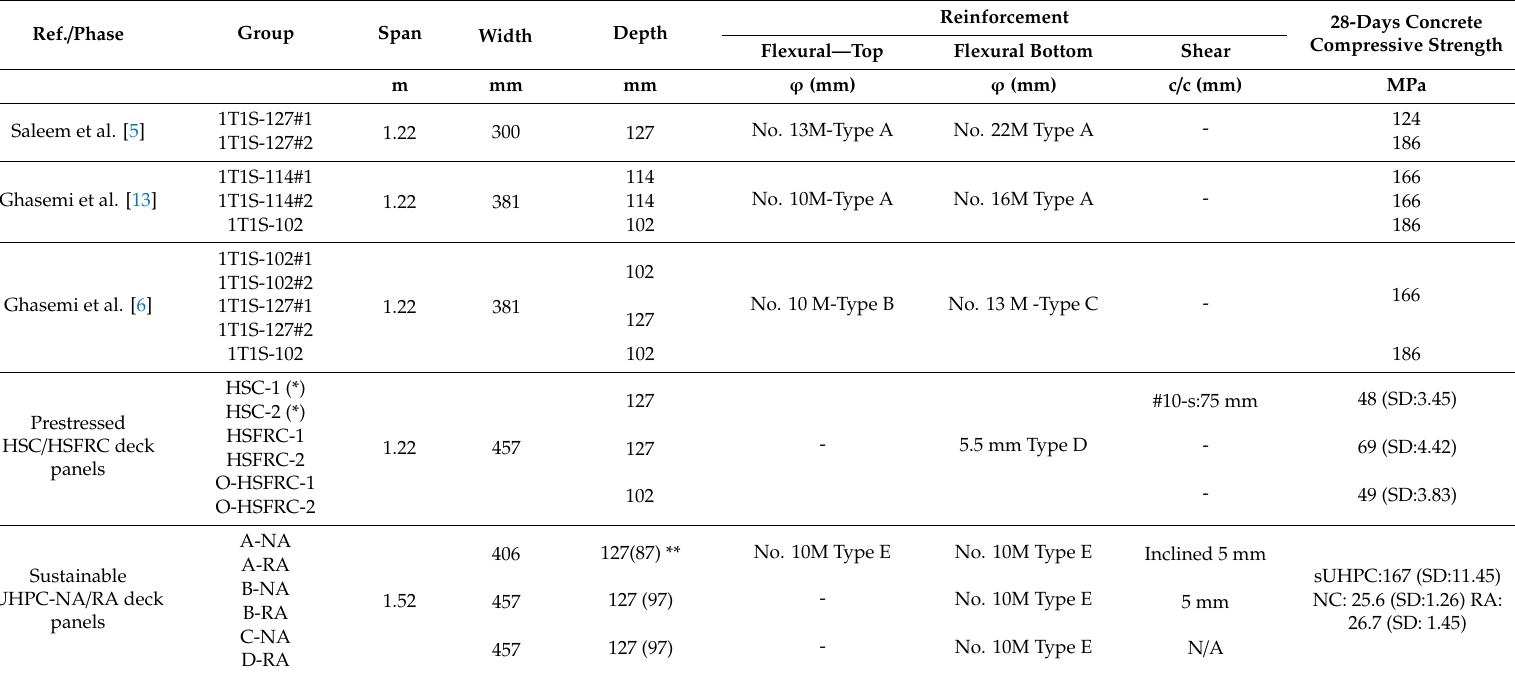
Table 1. Test matrix and specimen